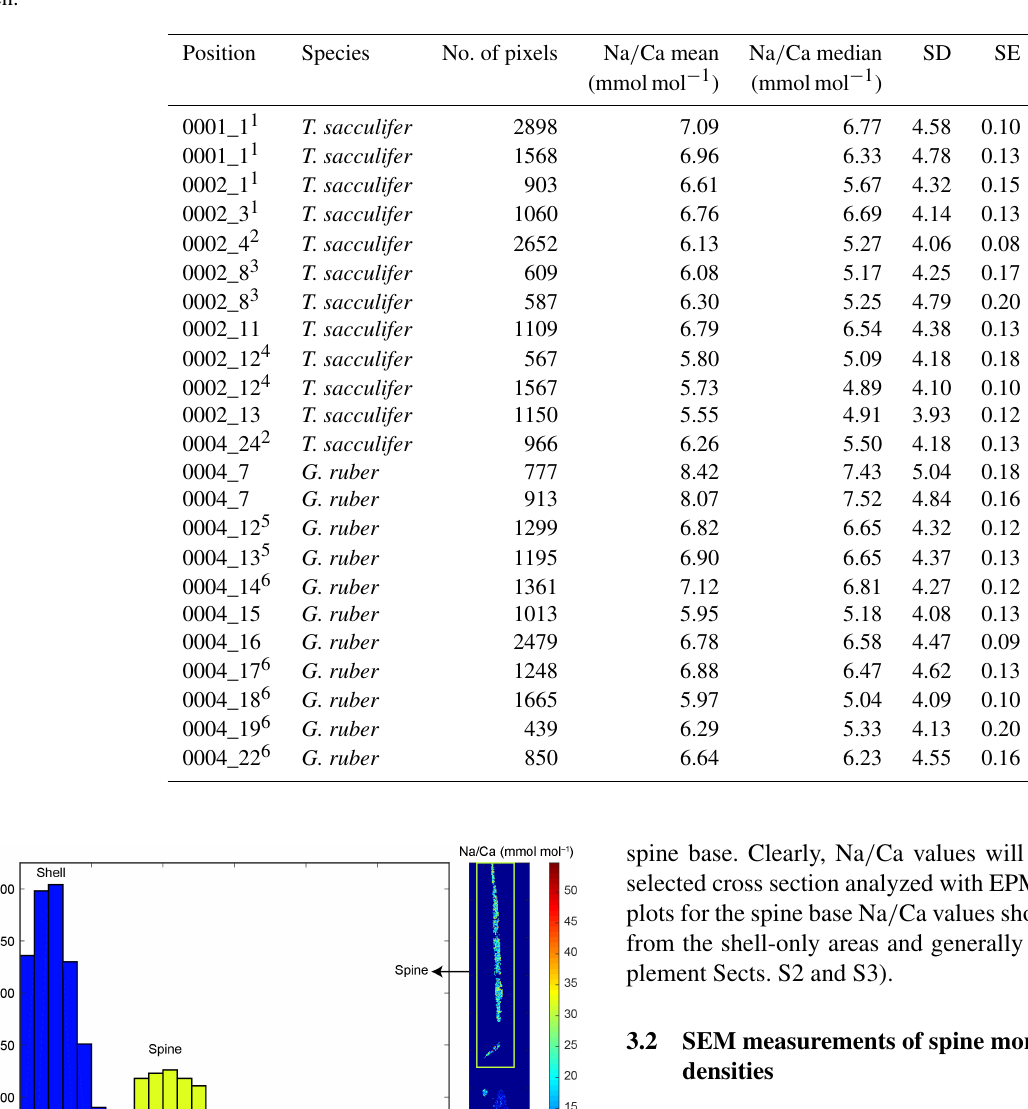
Table 3. Overview of multi-net Na / Ca shell values. Similar superscript numbers indicate that these are measurements from the same speci- men.